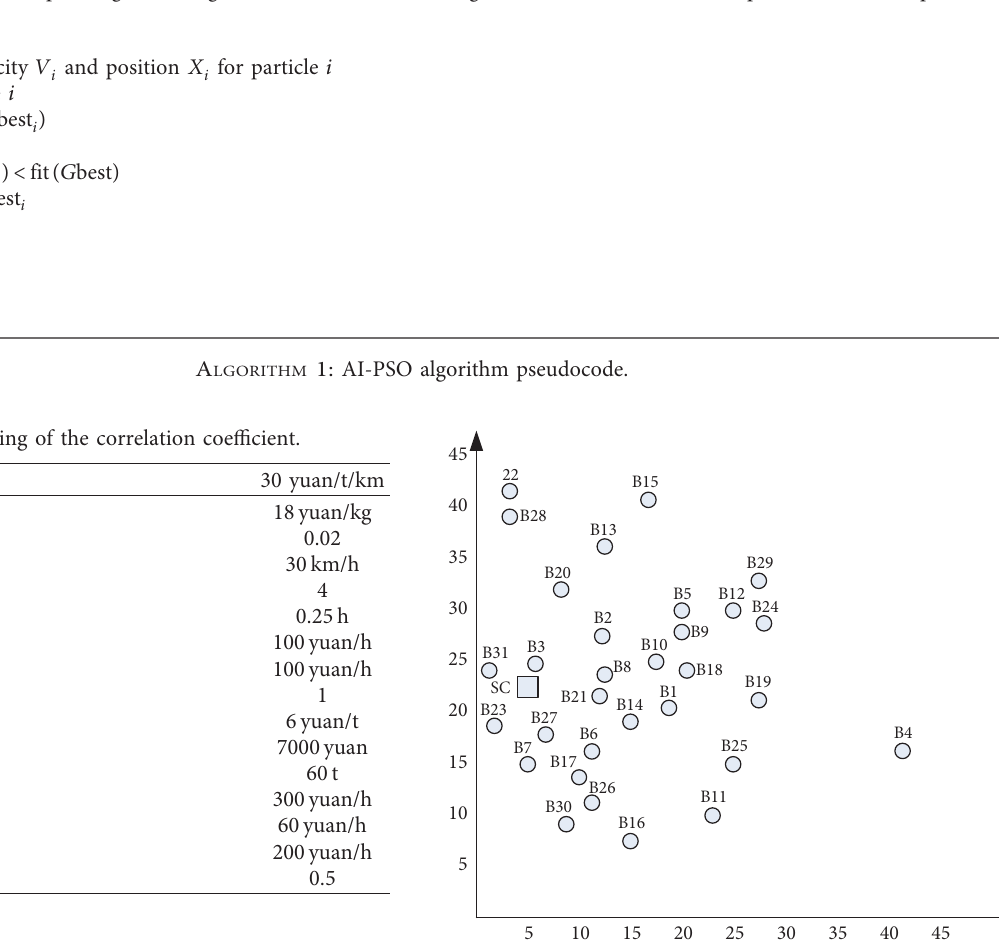
Figure 4: Spatial layout of suppliers and